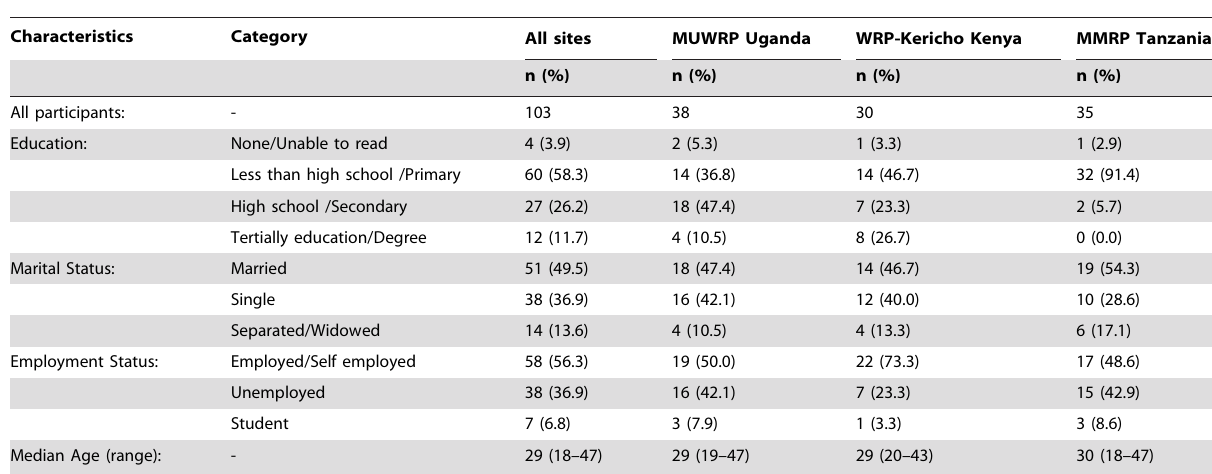
Table 1. Demographic Characteristics of Female Study Participants by Site